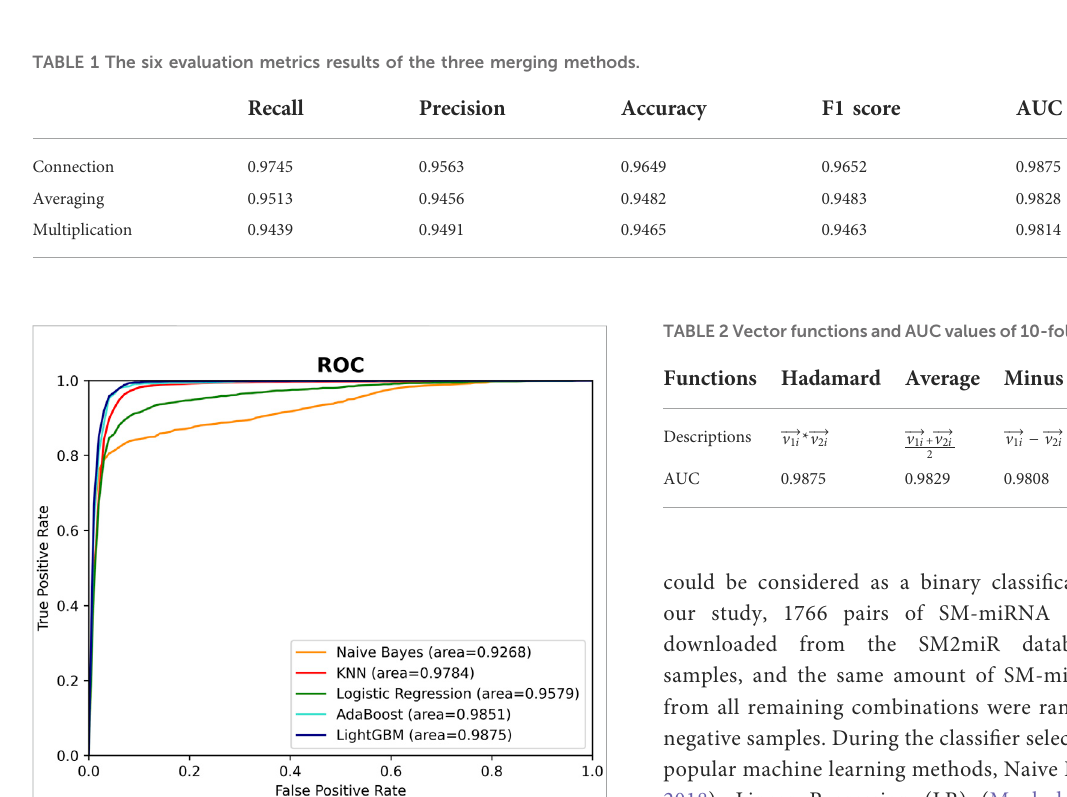
FIGURE 5 The ROC curves of different classi fi ers.